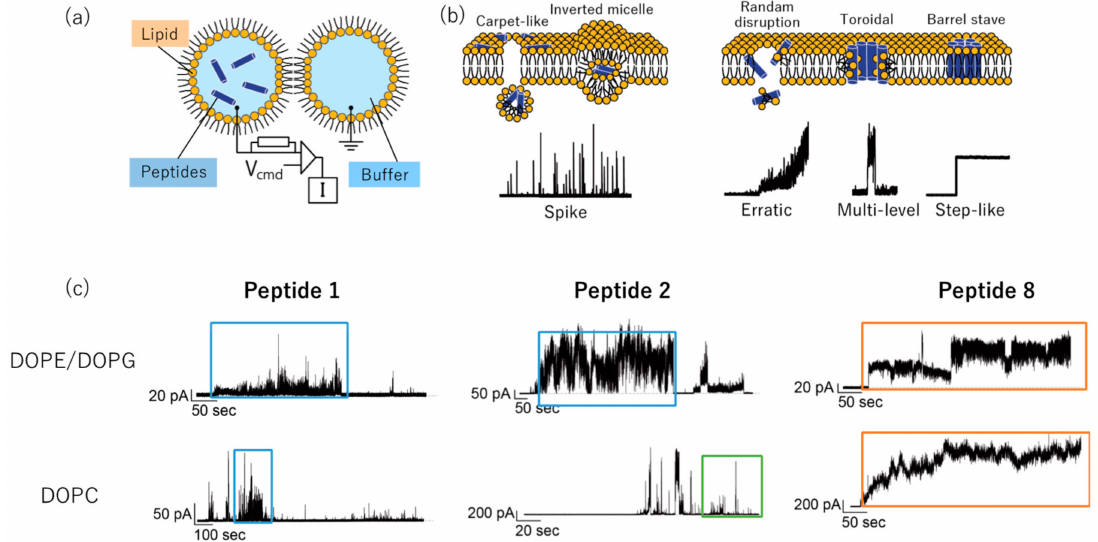
Figure 3. ( a ) Electrophysiological measurement [18]. ( b ) Typical current patterns with the treatment of cell penetrating peptides (CPPs) and antimicrobial peptides (AMPs) [18]. ( c ) The electrophysiological signals during treatment of peptides 1 , 2, and 8 at 100 nM.